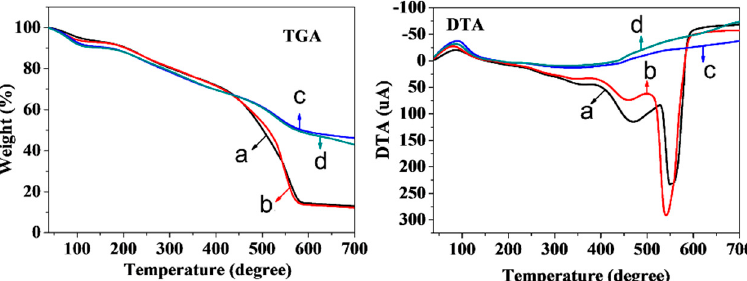
Figure 7. TGA and DTA curves of ( d ) control and ( a–c ) precursors in 40 wt% ZnCl 2 solution using(a) ultrasound, ( b ) microwave, and ( c ) UV irradiation, respectively.